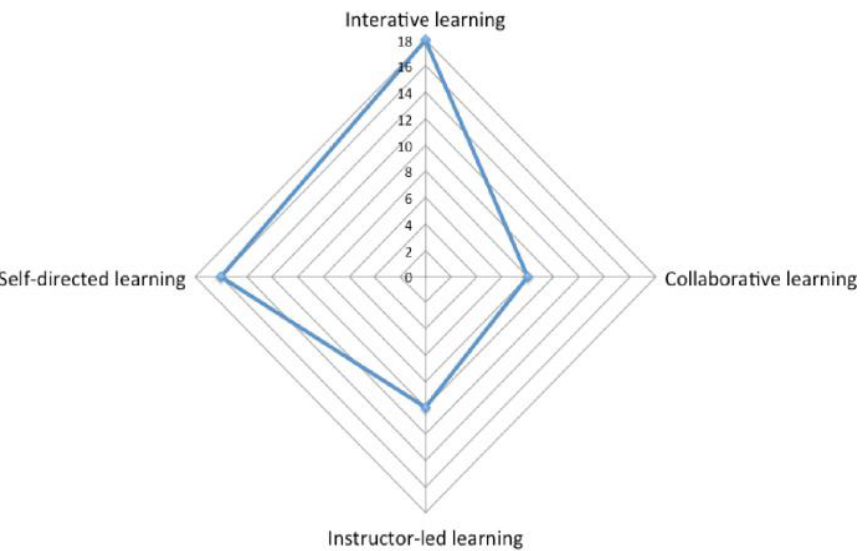
Fig. 4. Learners preferred mode of